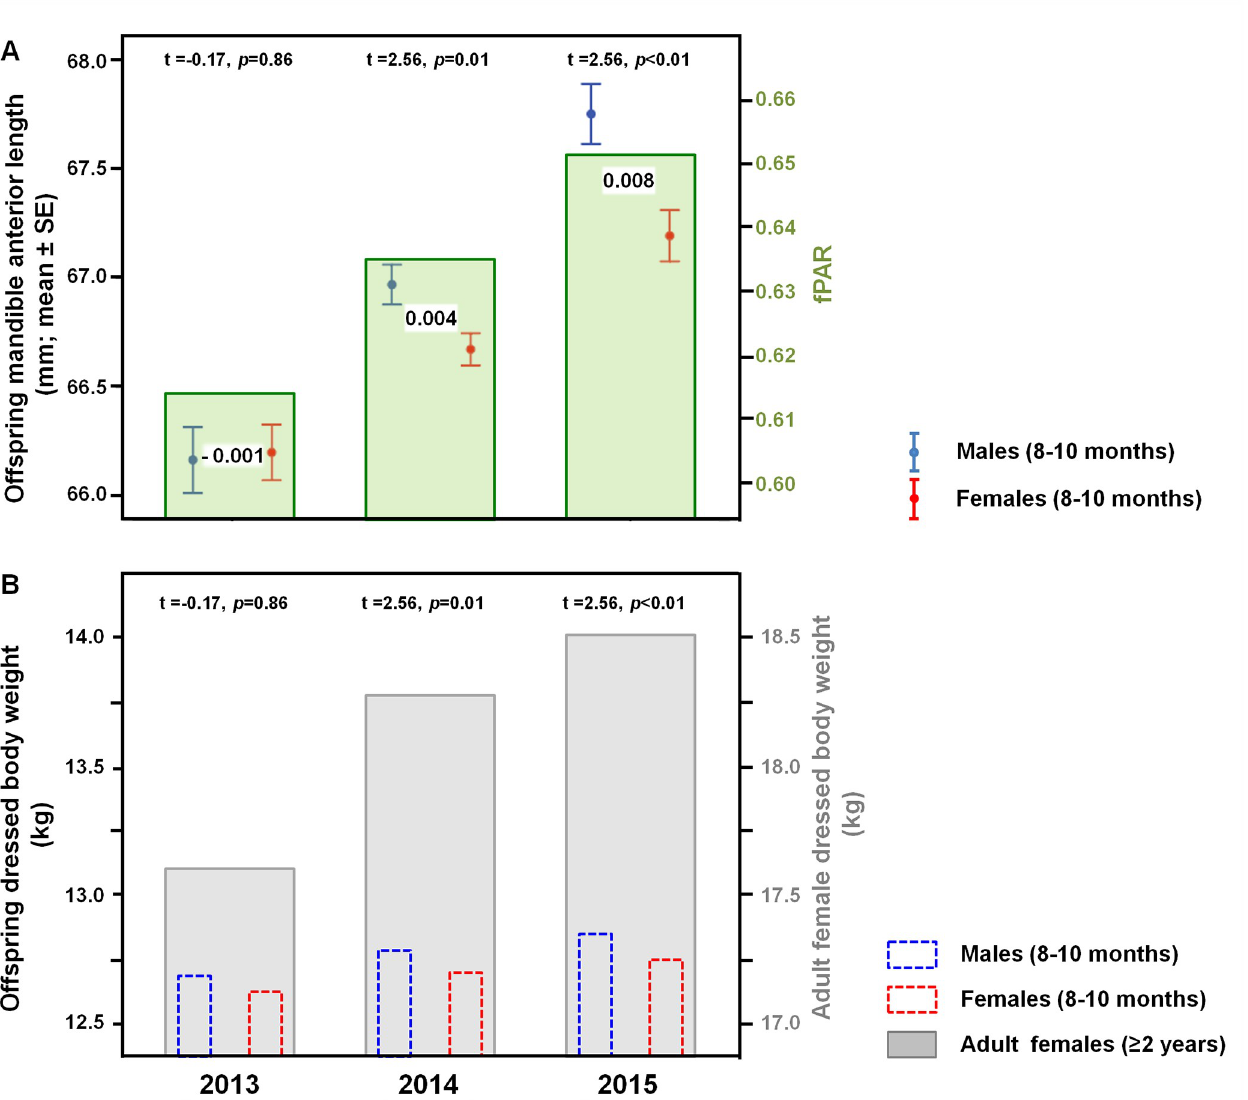
Fig 6. Mandible anterior section as an index of growth constraints. A: Length of the anterior section of 2,161 mandibles of juveniles (8–10 months; 1,176 females and 985 males) in relation to the forest productivity (fPAR) in March-October during the 2013–2015 hunting seasons (1 st January-15 th March) in the Arezzo province (Tuscany, Central Italy). SSD is reported for each year between error bars and differences between sexes were reported (t test). B: Dressed body weight of 2,161 juveniles (8–10 months; 1,176 females and 985 males) in relation to the dressed body weight of adult females ( � 2 years) during the 2013– 2015 hunting seasons (1 st January-15 th March) in the Arezzo province (Tuscany, Central Italy). Differences between sexes were reported (t test).